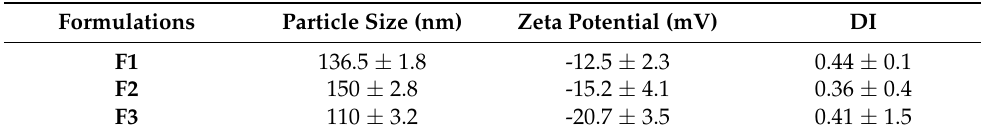
Table 2. Particle size, zeta potential and DI of KA-loaded